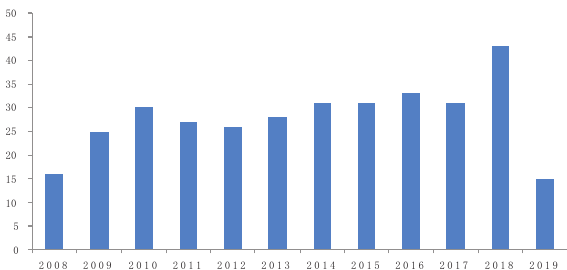
Figure 4. Distribution of the IJSPM publications by years